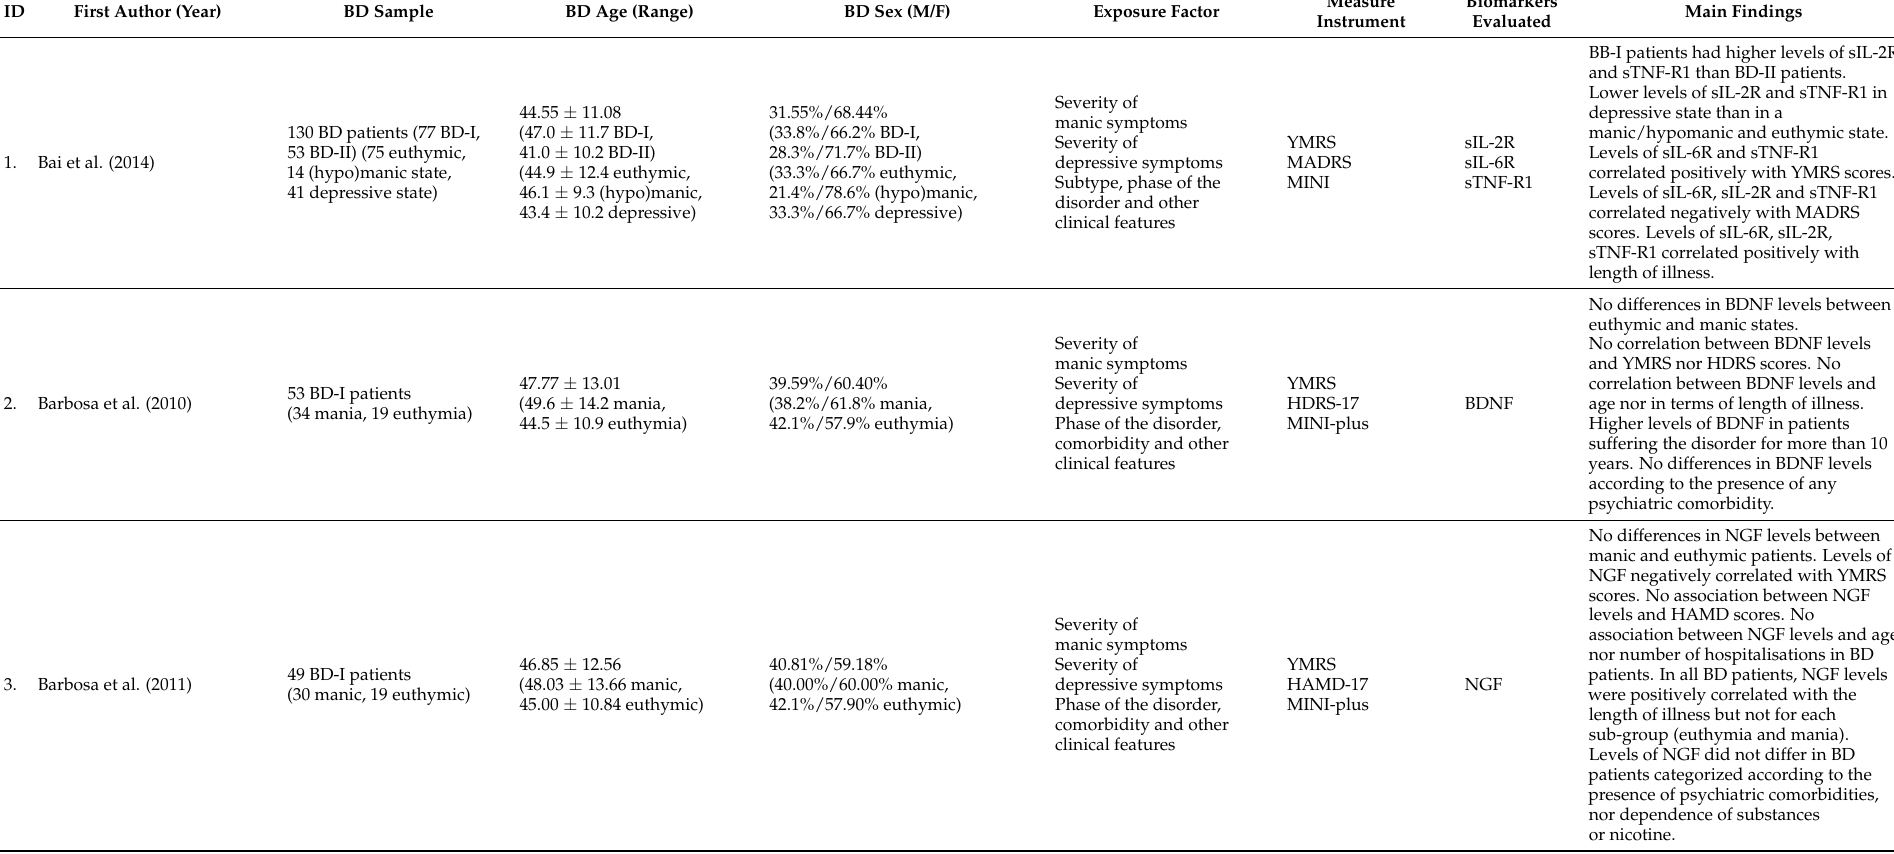
Table 1. Summary of the 51 studies analyzing 33 biomarkers in 4547 patients with a diagnosis of BD included in the systematic review and